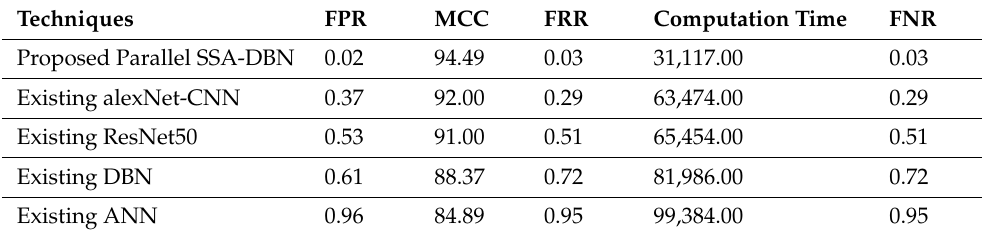
Table 2. Evaluation of classification metrics for proposed parallel SSA-DBN on FPR, MCC, FRR, computation time and FNR.